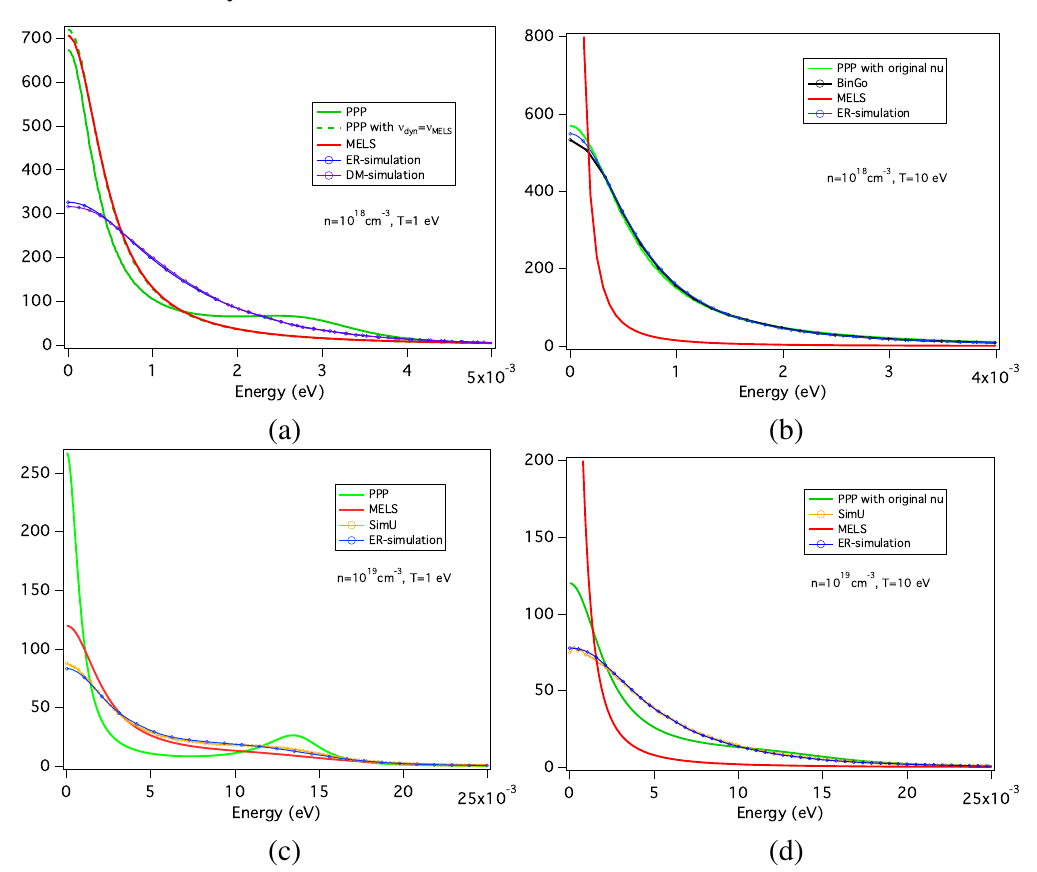
Figure 11. Spectral line shapes of the Lyman- α line in a pure rotating field. Comparisons of the results obtained by the different